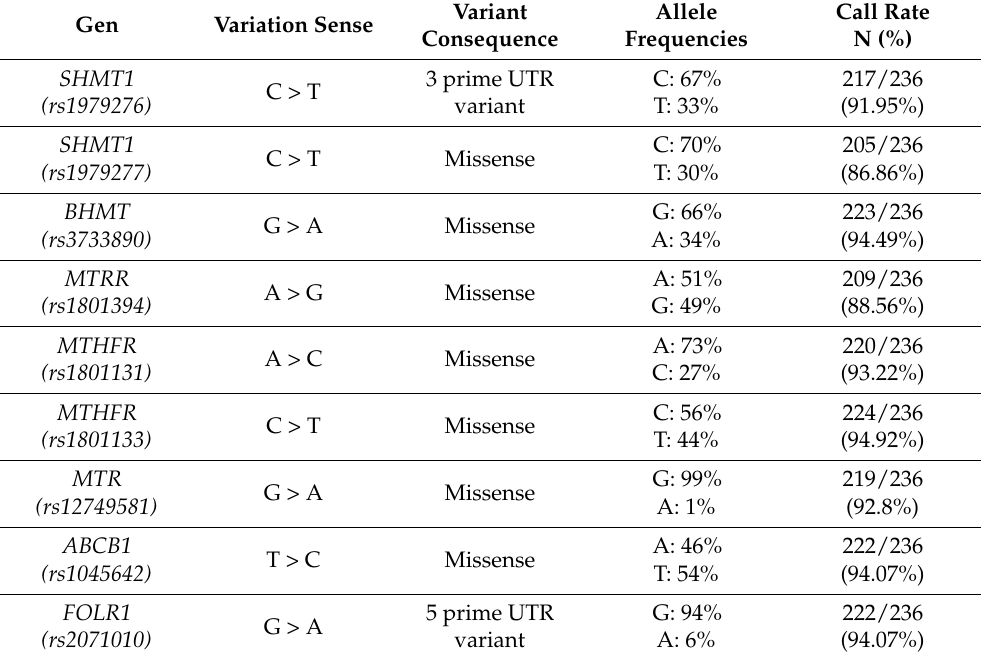
Table 1. Detail and description of candidate gene variants related to folate mediated one-carbon metabolism pathway and selected for the present study.